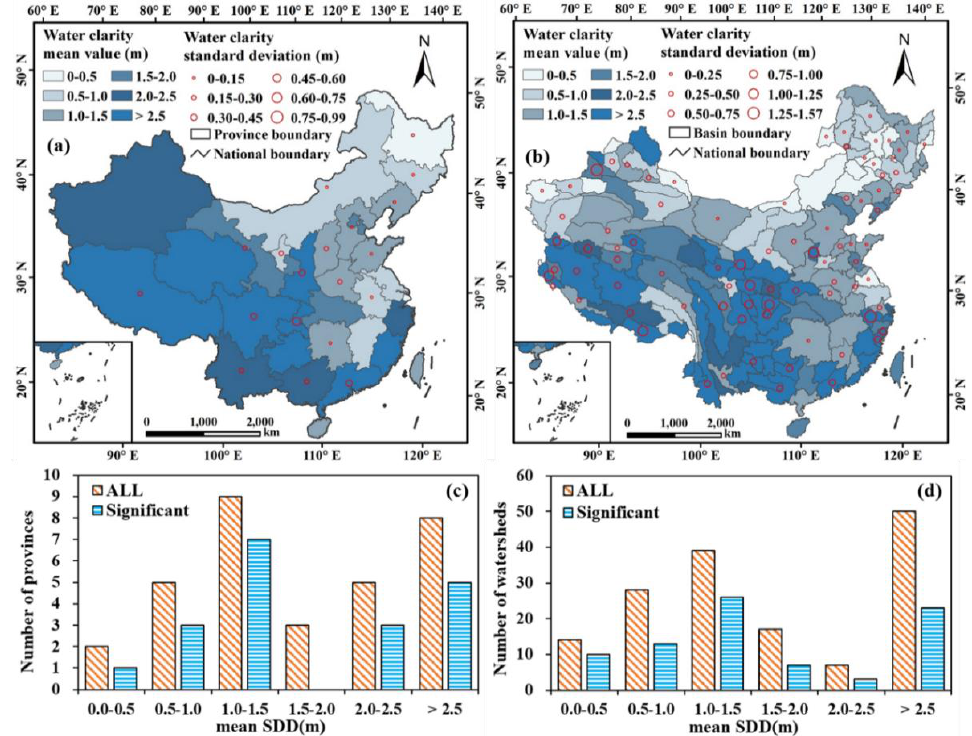
Figure 3. Average and standard deviation (red circles) of lake SDD during 1984 – 2018 by provinces ( a ) and by watersheds ( b ). Standard deviation data are presented only for the 19 provinces ( a ) and 82 watersheds ( b ) that had shown significant ( p < 0.05) trends in interannual changes in mean SDD. The histograms showed the distribution of lake SDD among provinces ( c ) and watersheds ( d ). Histograms ( c , d ) are drawn for all lakes (brown hatched bars) and for the subset of lakes where a significant trend in SDD was detected.